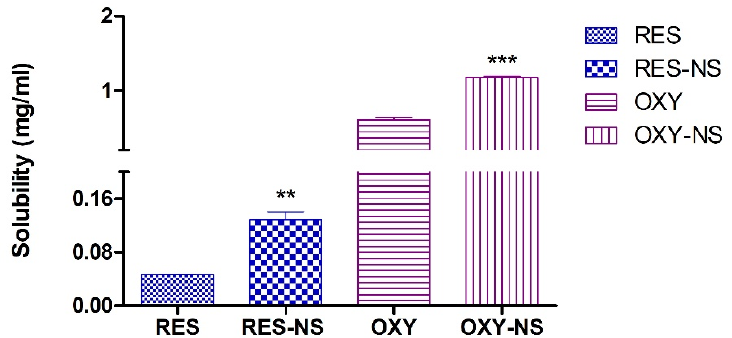
Figure 3. Solubilization of resveratrol (RES) and oxyresveratrol (OXY) in presence of nanosponges (NSs). ** p < 0.001, and *** p < 0.0001 indicates a significant difference between RES vs RES-NS or OXY vs OXY-NS.